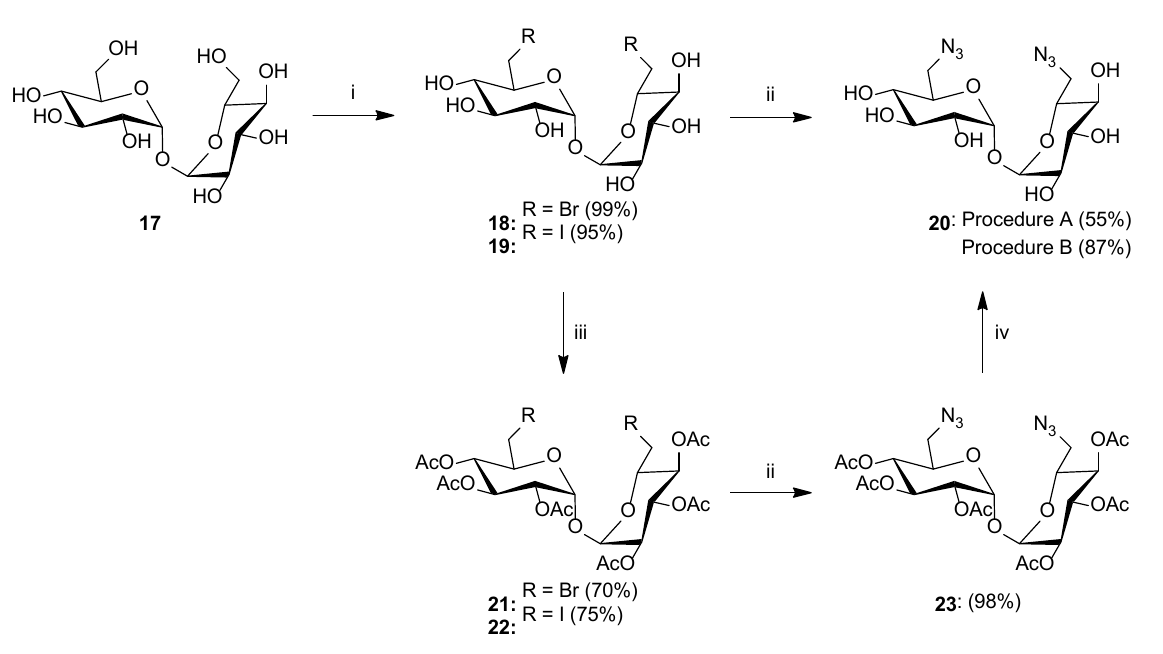
B-1 : (86%) B-2 : (64%) Scheme 6. Synthesis of type B glycoconjugates. Reagents and Conditions: ( i ) CuSO 4 ·5H 2 O, NaAsc, i - PrOH/THF/H 2 O (1:1:1, v : v : v ), r.t., 24 h.